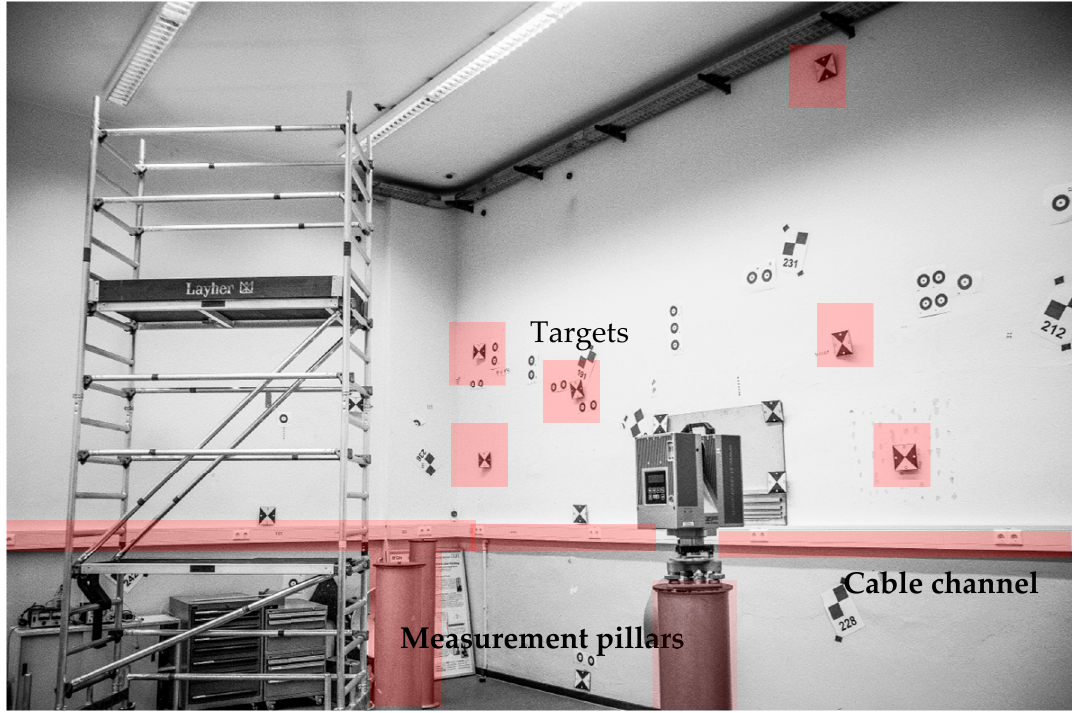
Figure 2. 3D-laboratory of the Geodetic Institute Hanover (GIH) with measurement pillars and cable channel.